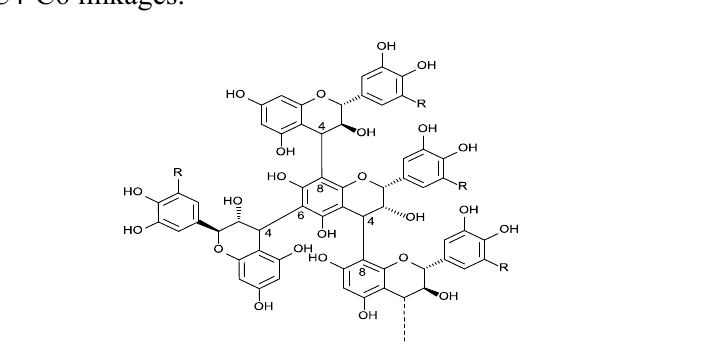
Figure 2. General structures of proanthocyanidins: flavan-3-ol monomers are linked through C4-C8 or C4-C6